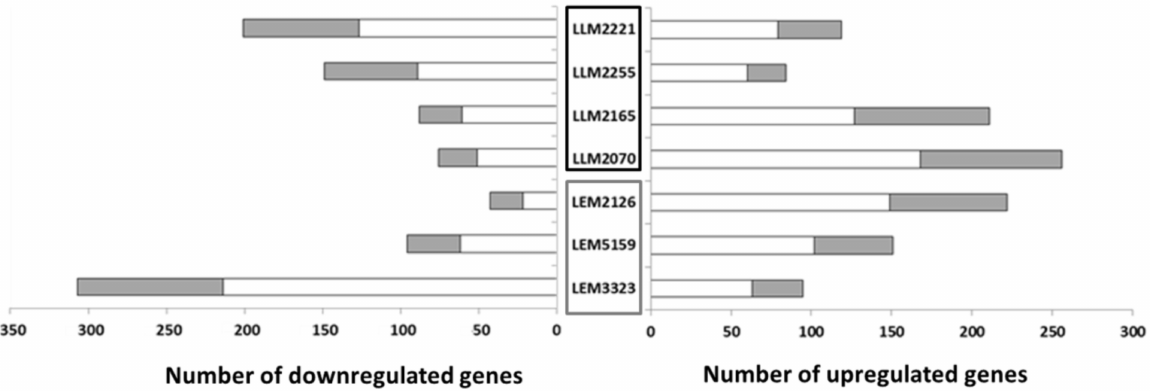
Figure 1. Differentially expressed genes (DEGs) in the Leishmania lines after infection of THP-1 cells. The number of DEGs in comparison with the reference line (LJPC) is shown. The gray section of each bar represents the number of DEGs that code for hypothetical proteins. Therapeutic failure lines are included in the black box, drug-resistant lines in the gray